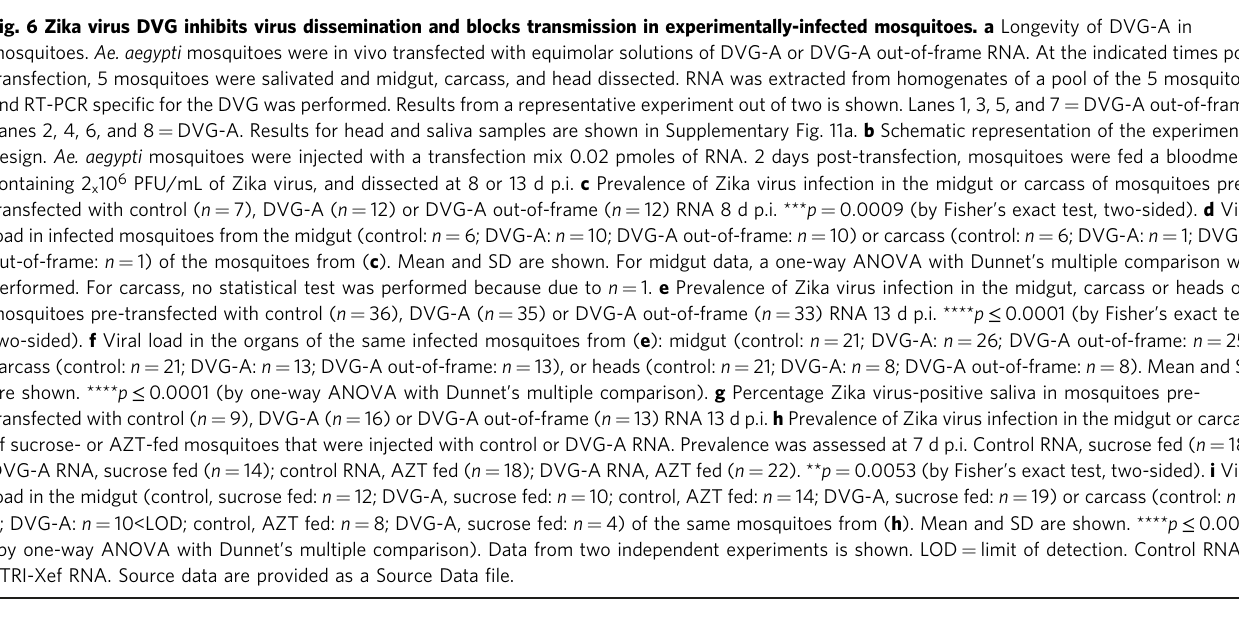
Fig. 6 Zika virus DVG inhibits virus dissemination and blocks transmission in experimentally-infected mosquitoes. a Longevity of DVG-A in mosquitoes. Ae. aegypti mosquitoes were in vivo transfected with equimolar solutions of DVG-A or DVG-A out-of-frame RNA. At the indicated times post transfection, 5 mosquitoes were salivated and midgut, carcass, and head dissected. RNA was extracted from homogenates of a pool of the 5 mosquitoes and RT-PCR speci fi c for the DVG was performed. Results from a representative experiment out of two is shown. Lanes 1, 3, 5, and 7 = DVG-A out-of-frame, Lanes 2, 4, 6, and 8 = DVG-A. Results for head and saliva samples are shown in Supplementary Fig. 11a. b Schematic representation of the experimental design. Ae. aegypti mosquitoes were injected with a transfection mix 0.02 pmoles of RNA. 2 days post-transfection, mosquitoes were fed a bloodmeal containing 2 x 10 6 PFU/mL of Zika virus, and dissected at 8 or 13 d p.i. c Prevalence of Zika virus infection in the midgut or carcass of mosquitoes pre- transfected with control ( n = 7), DVG-A ( n = 12) or DVG-A out-of-frame ( n = 12) RNA 8 d p.i. *** p = 0.0009 (by Fisher ’ s exact test, two-sided). d Viral out-of-frame: n = 1) of the mosquitoes from ( c ). Mean and SD are shown. For midgut data, a one-way ANOVA with Dunnet ’ s multiple comparison was performed. For carcass, no statistical test was performed because due to n = 1. e Prevalence of Zika virus infection in the midgut, carcass or heads of mosquitoes pre-transfected with control ( n = 36), DVG-A ( n = 35) or DVG-A out-of-frame ( n = 33) RNA 13 d p.i. **** p ≤ 0.0001 (by Fisher ’ s exact